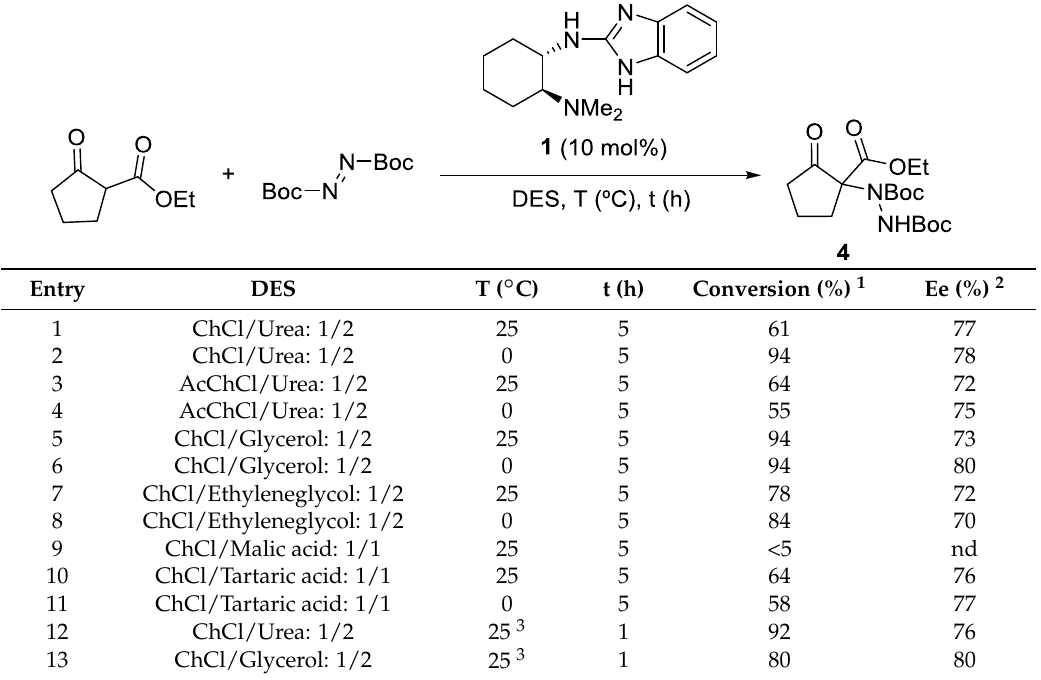
Table 1. Asymmetric α-amination of ethyl 2-oxocyclopentane-1-carboxylate with di- tert -butyl azodicarboxylate (DBAB). Deep eutectic solvents (DES) study.